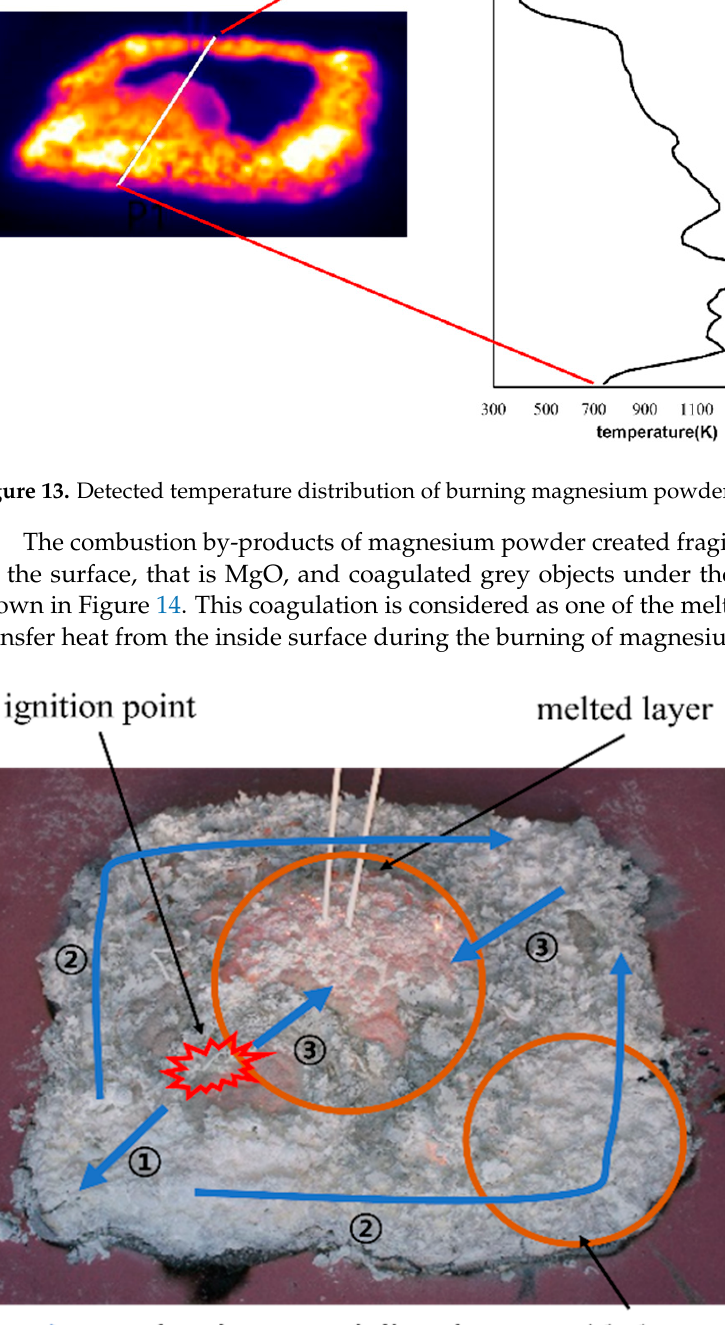
Figure 14. Combustion directions on the by-products of magnesium.